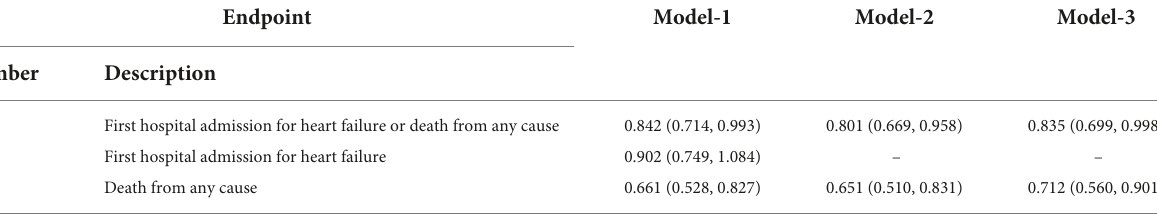
TABLE 2 Effect of sex on the primary outcome and its components (hazard ratio; 95% confidence interval)*.